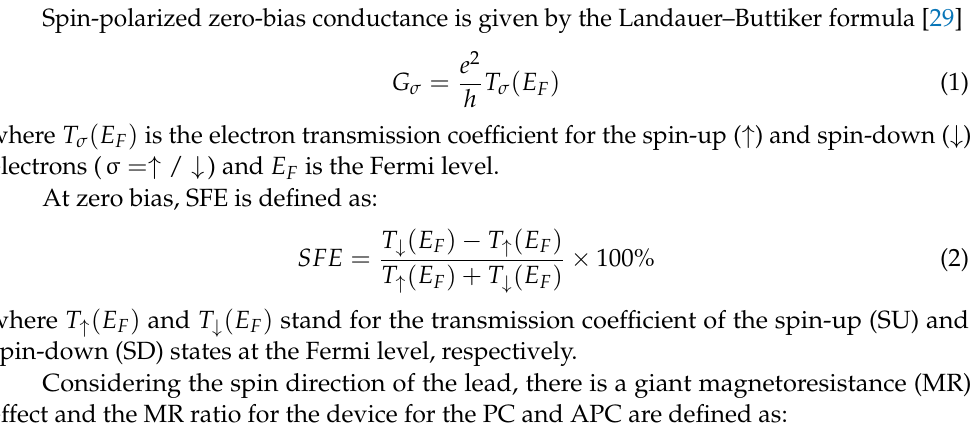
Table 1. Optimized bond lengths between the 3d metal center (M) and the nearest nitrogen (N) atoms for Fe-/-Co-/-Cu-phthalocyanines in the gas phase. The experimental values are also given for comparison.